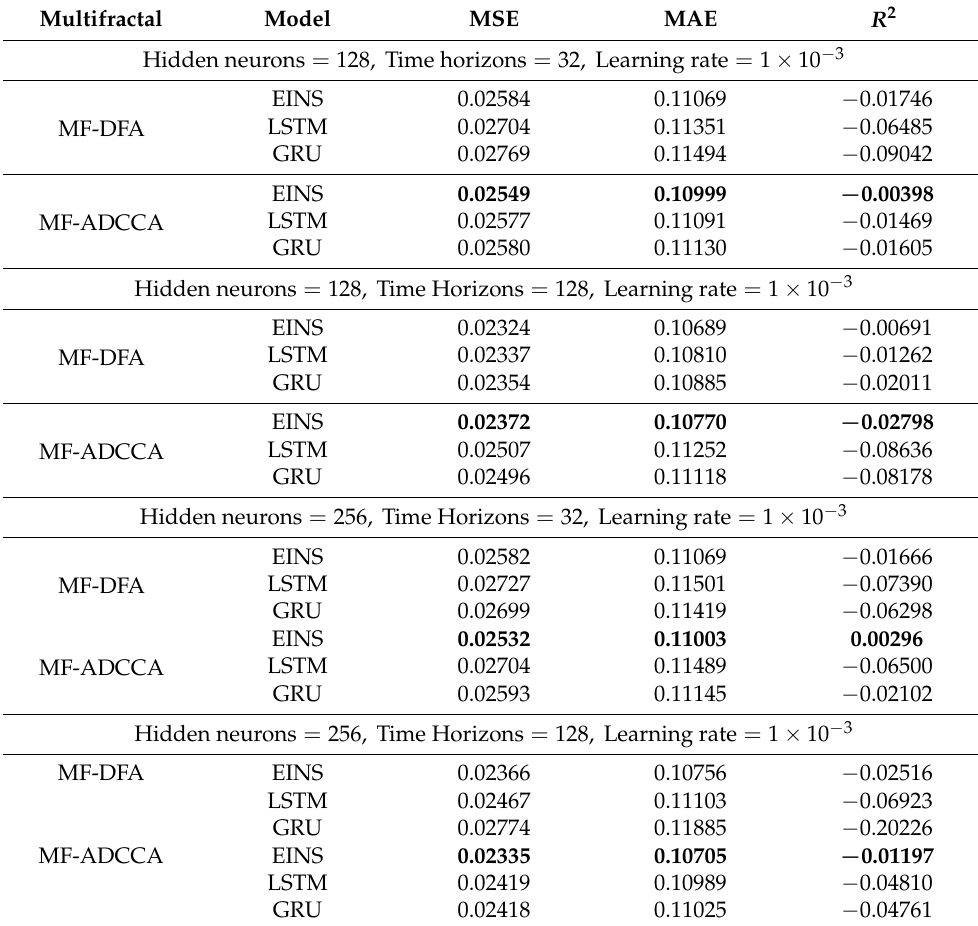
Table 3. Forecasting performance with various hyper-parameters (note: best results highlighted in BOLD